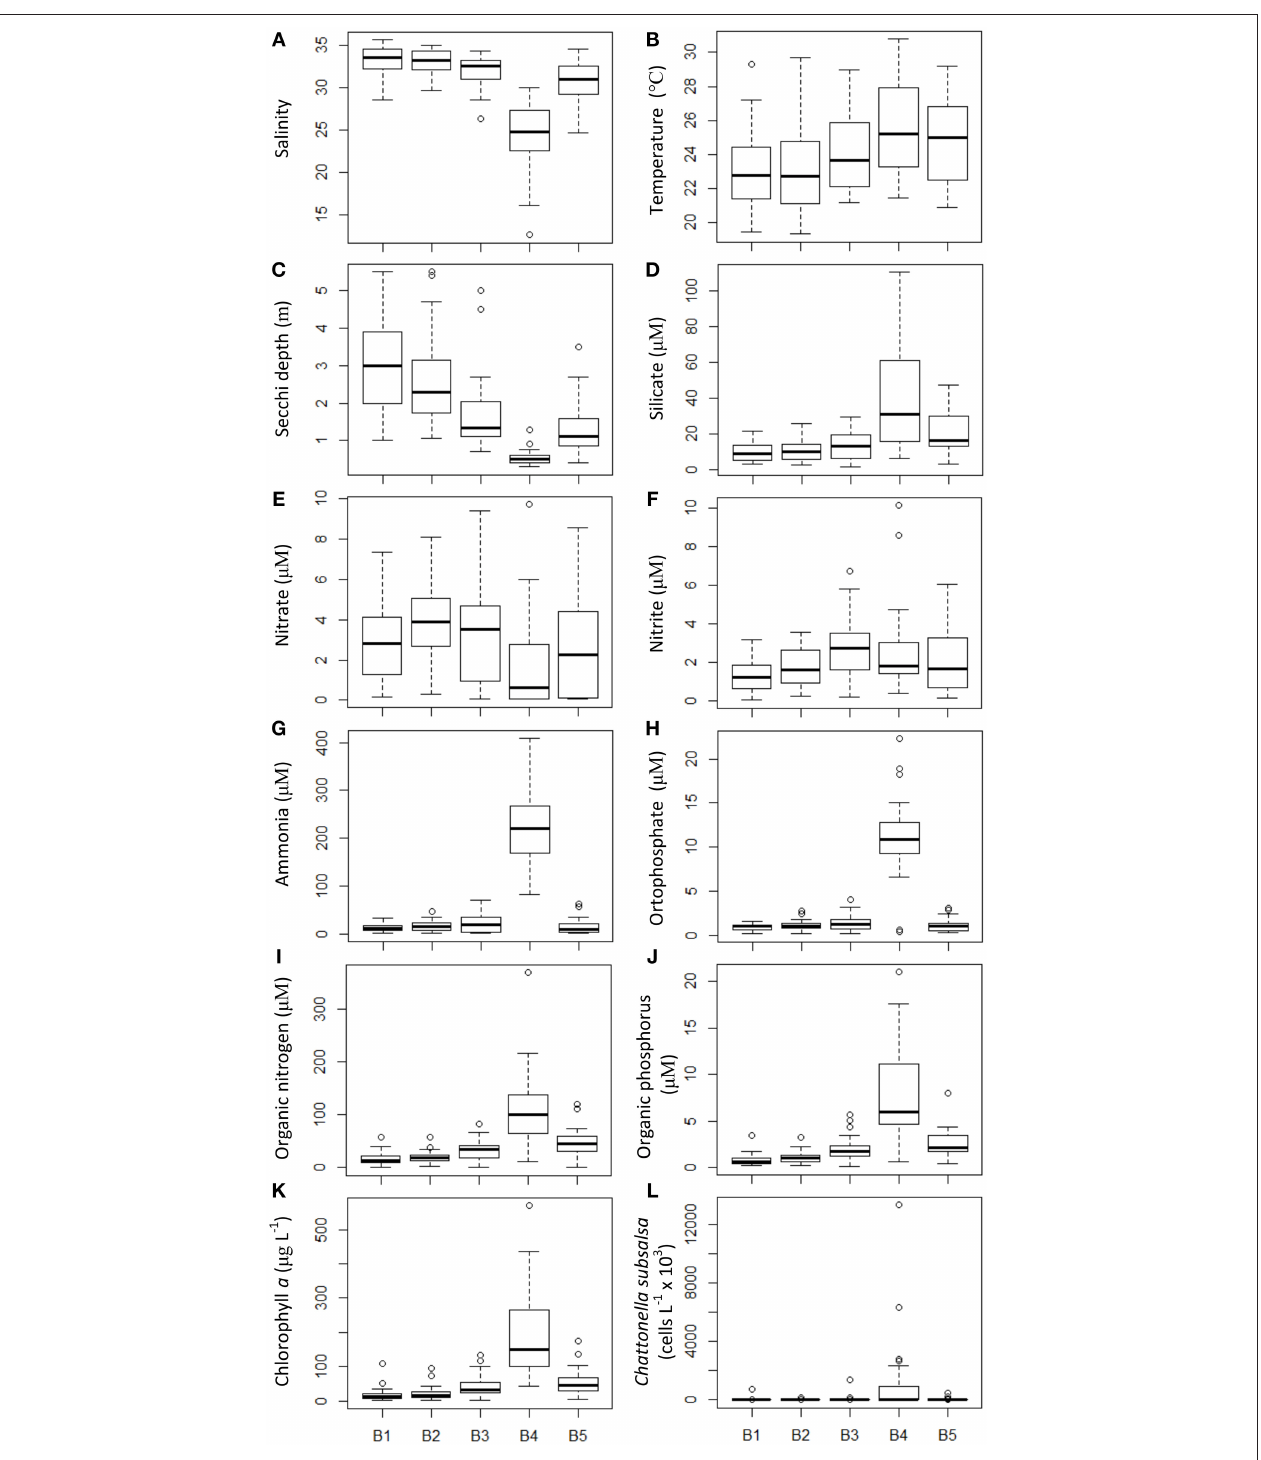
FIGURE 2 | Physical and chemical water parameters and C. subsalsa cell concentration in five locations (B1 to B5, see map in Figure 1 ) in Guanabara Bay sampled on a monthly basis from October 2014 to January 2018. (A) salinity; (B) water temperature; (C) Secchi depth; (D) silicate; (E) nitrate; (F) nitrite; (G) ammonia; (H) orthophosphate; (I) organic nitrogen; (J) organic phosphorus; (K) chlorophyll a ; (L) C. subsalsa cell concentration. The box plot shows mean (thick line inside the box), first and third quartiles (lower and upper box limits), standard deviation (whiskers) and outliers (open circles beyond the whiskers).